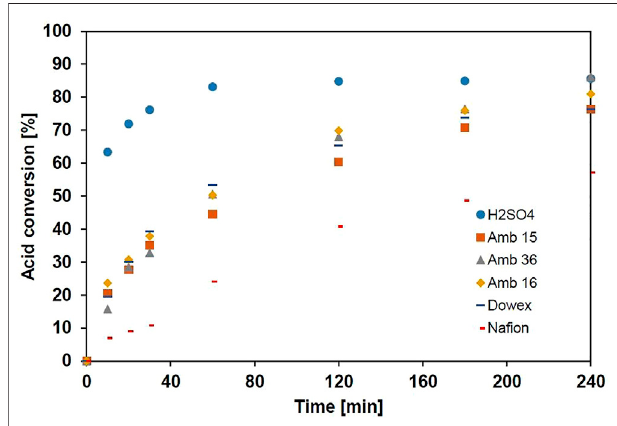
FIGURE 7 | Effect of catalyst type on glycolic acid conversion rate with